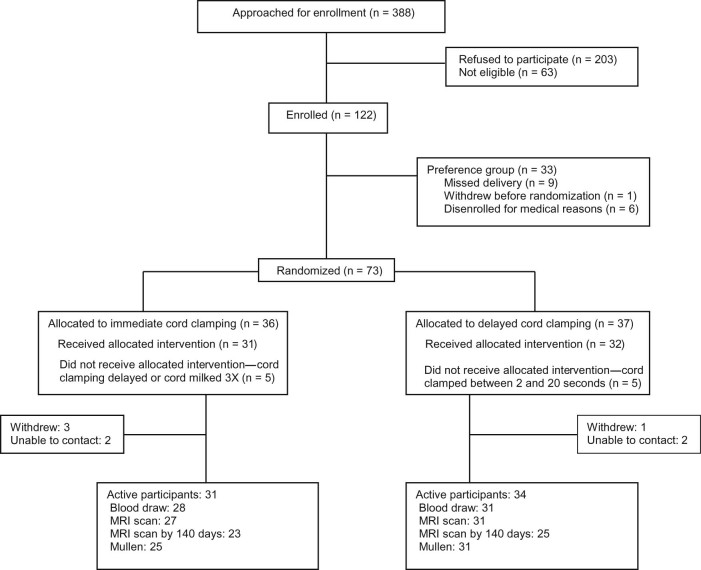
Infant brain study 4-month randomized cohort flowchart.